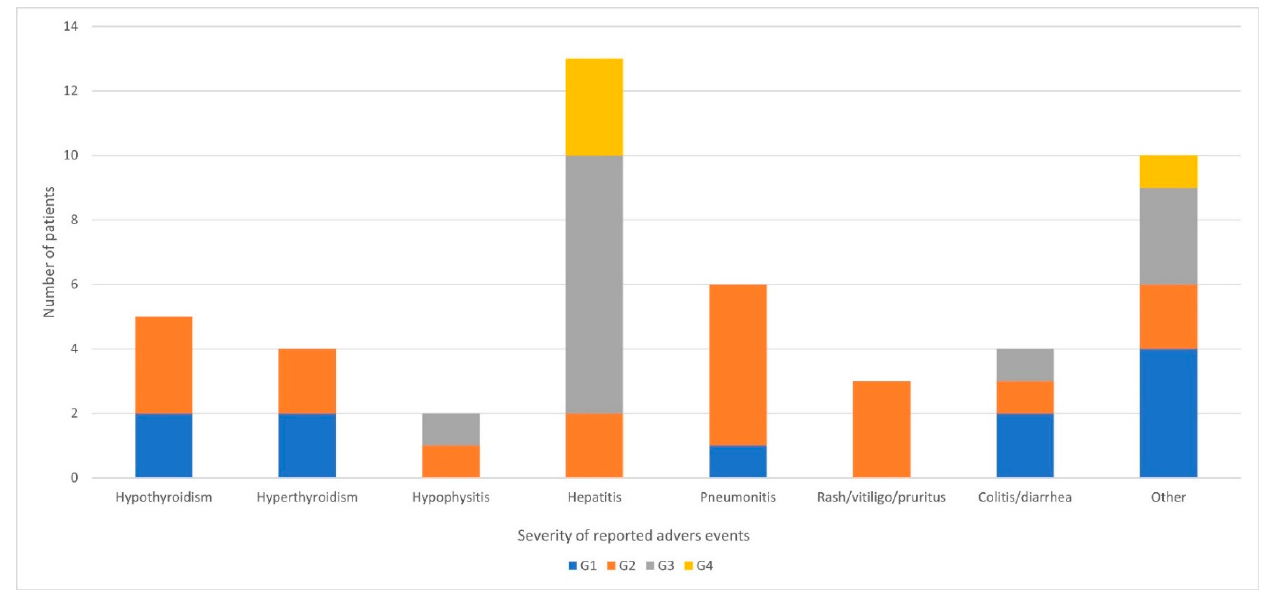
Figure 3. Prevalence and grade (according to CTCAE version 5.0, U.S. Department of Health and Human Services) [22]) of immunotherapy-related adverse events.